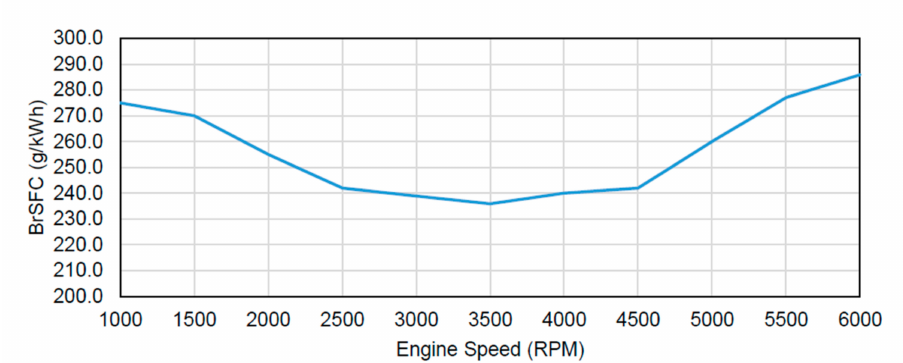
Figure 5. BSFC (Brake-specific fuel consumption) of Ford Eco Boost 1.6 L petrol engine at full load.